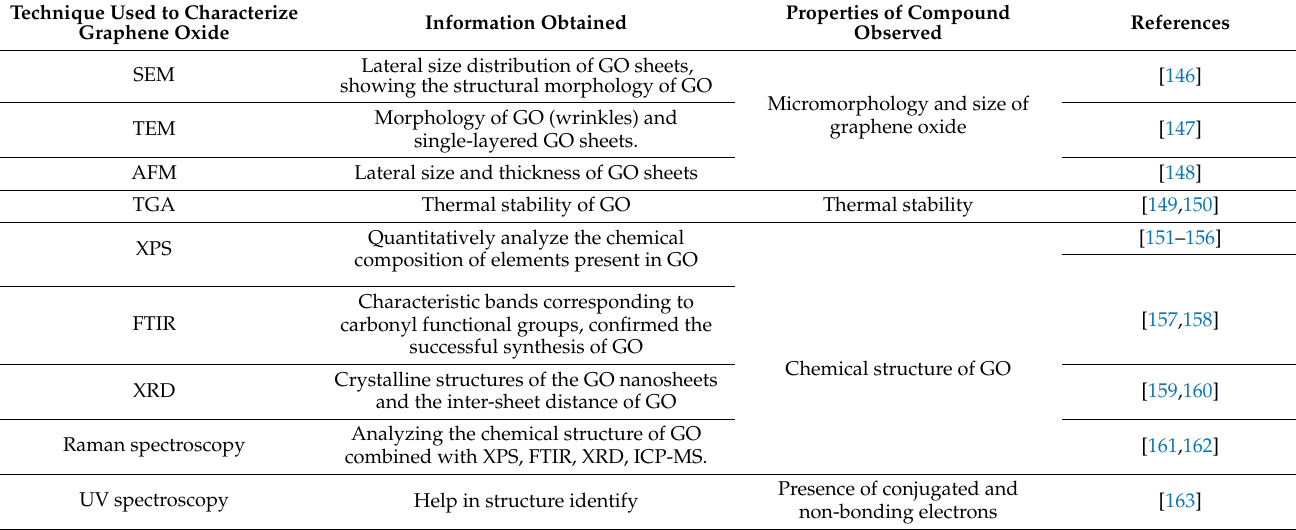
Table 5. Various techniques for the characterization of